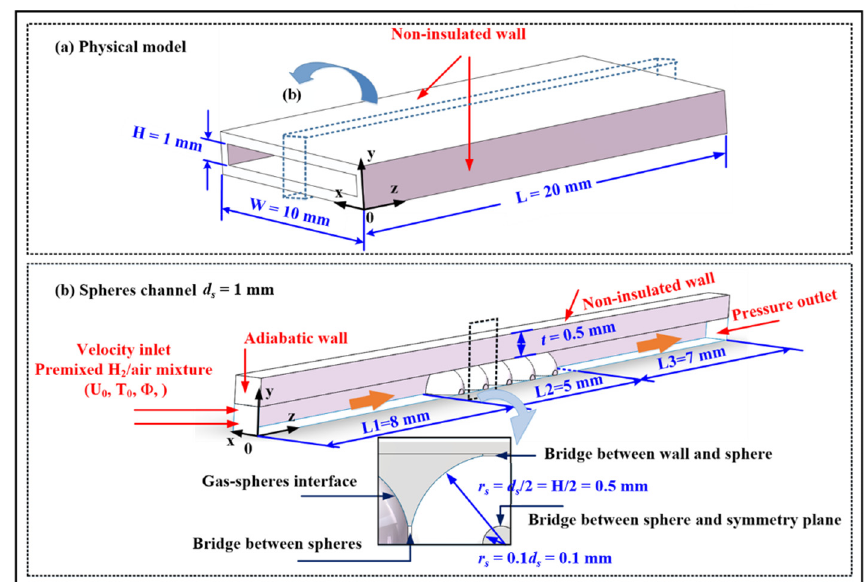
Figure 1. Illustration of porous micro-combustor in the PSM. ( a ) Physical model; ( b ) channel along the spheres.